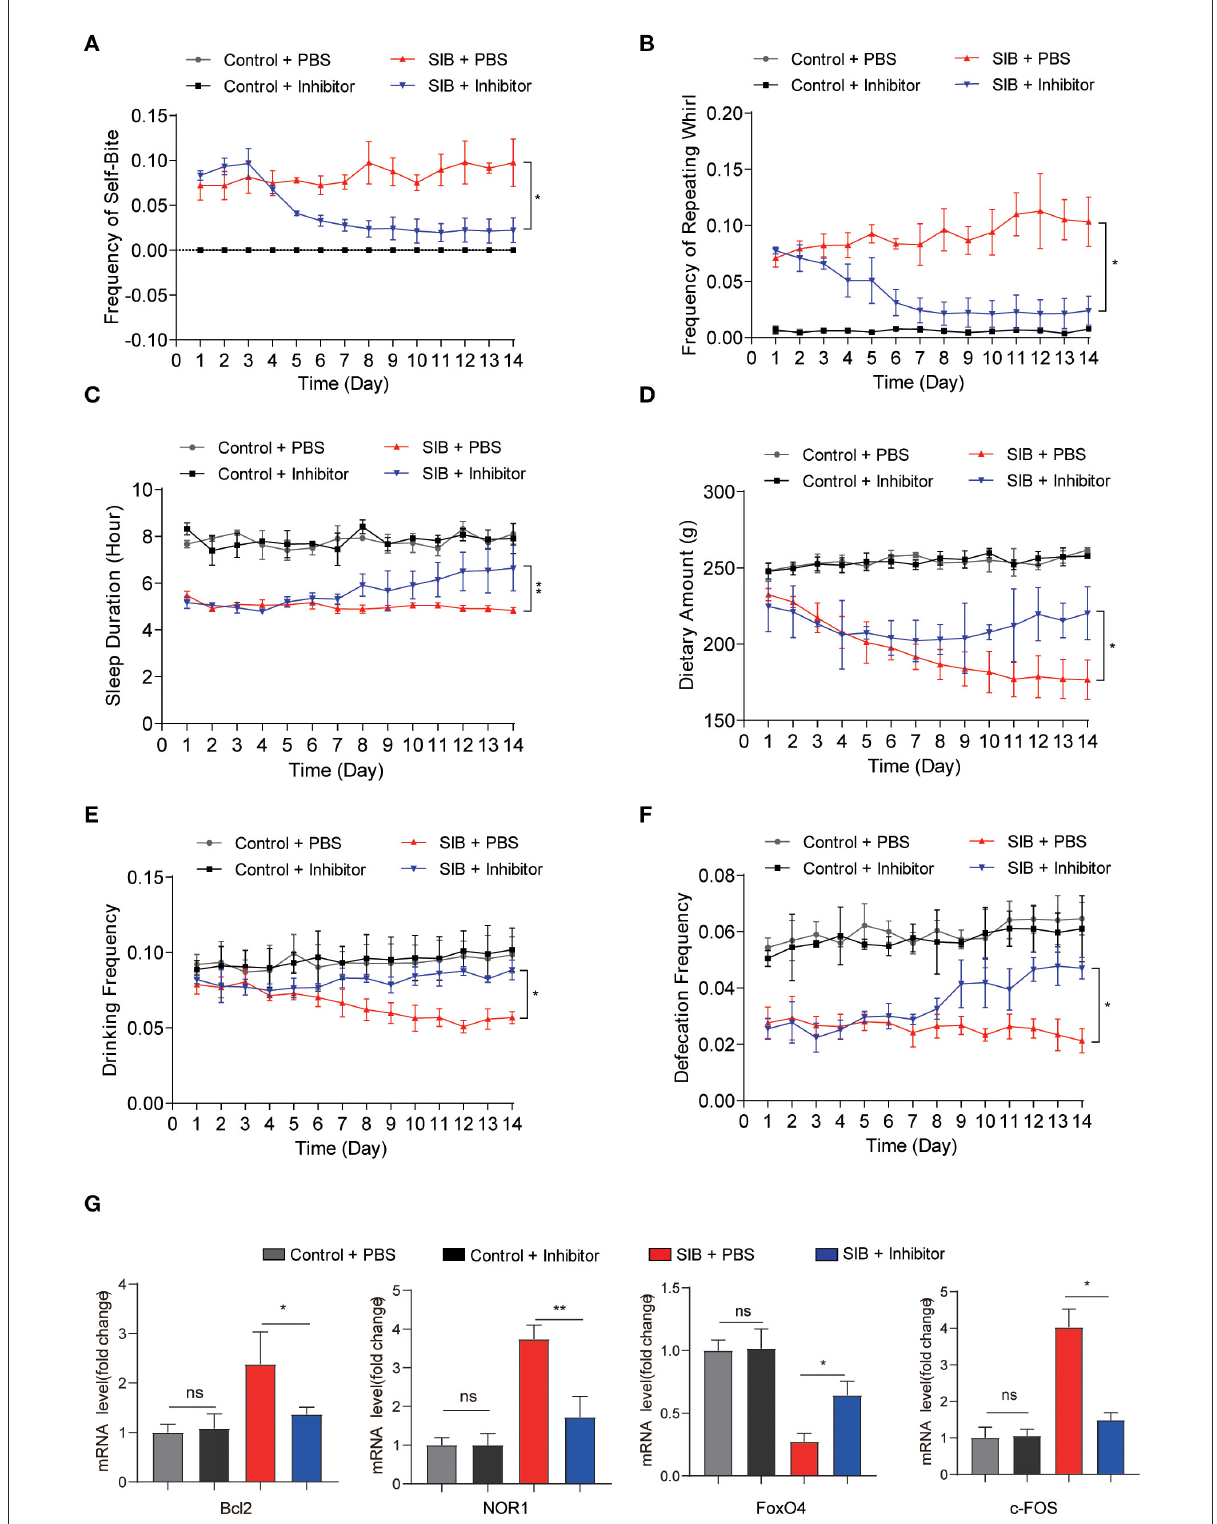
FIGURE4 CBP inhibitor significantly relieves SIB symptoms. (A,B) Frequency scores for self-biting and repeating whirl during 14 days. (C–F) Frequency scores for sleeping time, dietary amount, drinking frequency and defecation frequency during 14 days. (G) The mRNA levels of Bcl2 , NOR1 , FoxO4 , and c-FOS in brain tissues after 14 days treatment with inhibitor or PBS, assayed by qRT-PCR. Data shown represent the mean ± SEM; Control + PBS, n = 10; Control + inhibitor, n = 10; SIB + PBS, n = 13; SIB + inhibitor, n = 14. * p < 0.05, ** p < 0.01, n.s., no